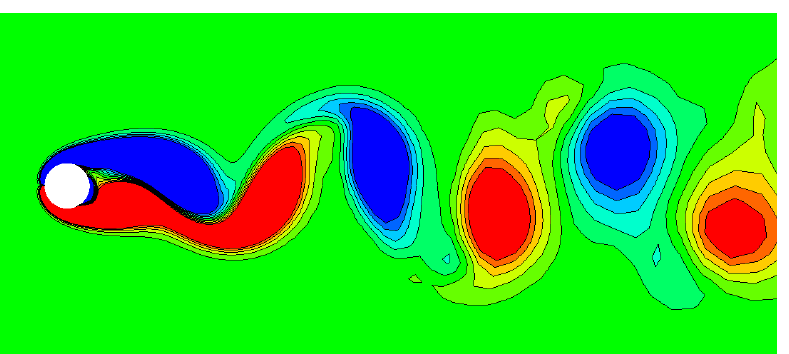
Figure 7. Contour of instantaneous spanwise vorticity ω z D / c ∞ in the near wake of flow over a circular cylinder; 10 contour levels from − 0.05 to 0.05 are shown.